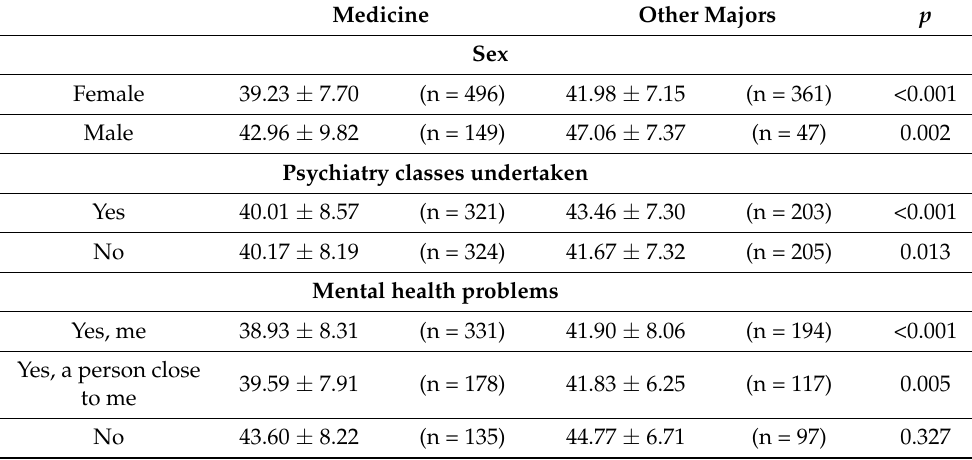
Table 3. The comparison of MICA-2 in relation to the